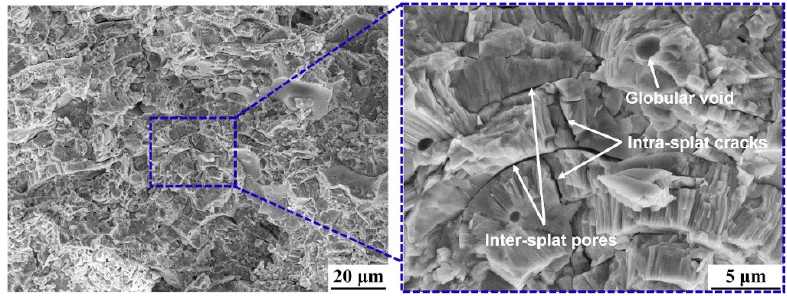
Figure 10. Fractured cross-section of as-deposited PS-TBC [61] .